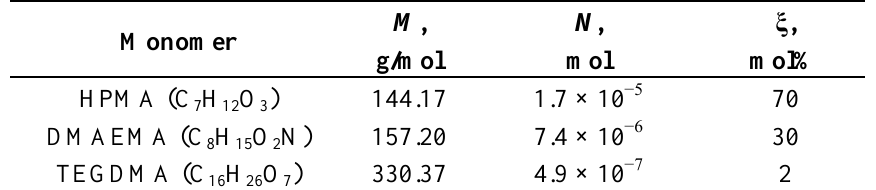
Table 4. Composition of the investigated HPMA/DMAEMA/TEGDMA layer.